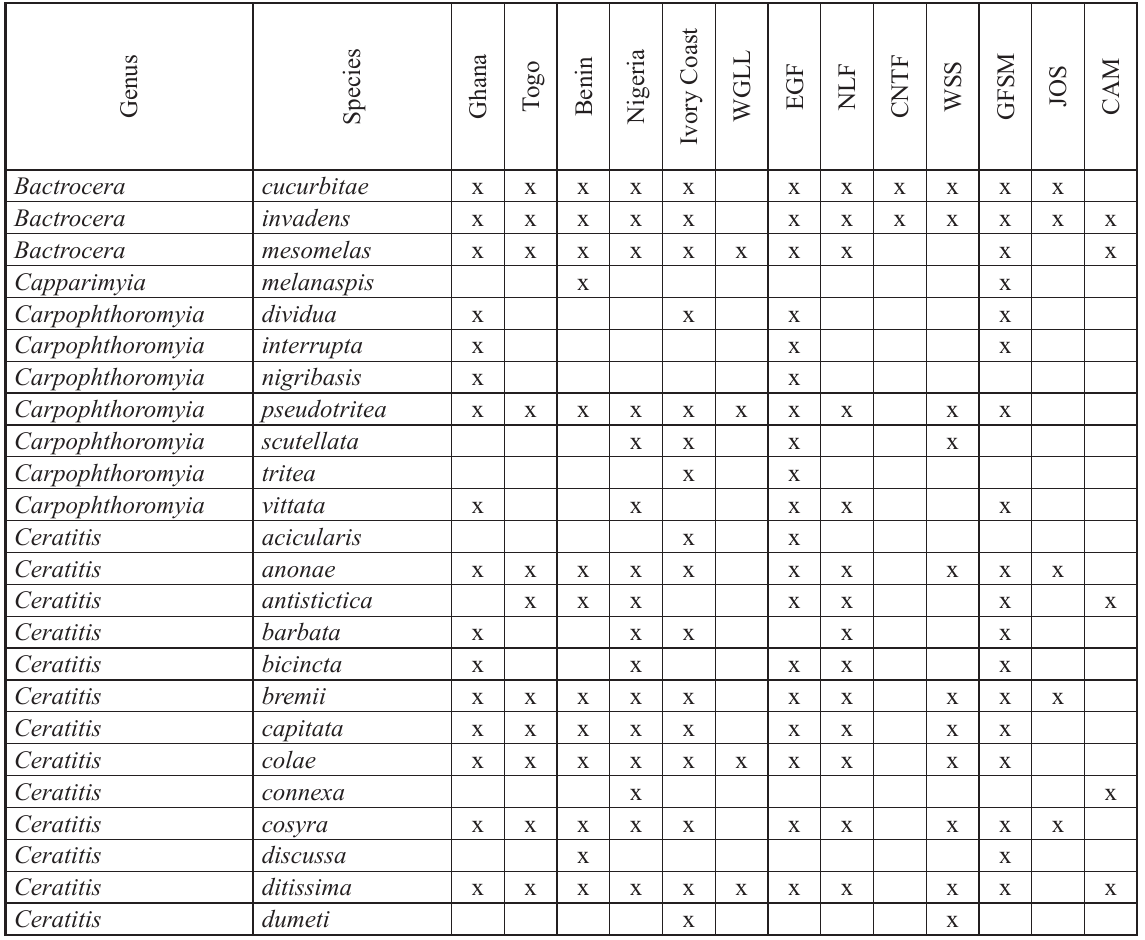
Table 1. List of tephritidae recorded from the different countries and ecoregions in the study area. (abbreviations: WGLL = West Guinean Lowland Forest; EGF = East Guinean Forest; NLF = Nigerian Lowland Forest; CNTF = Cross-Nigerian Transition Forest); WSS = West Sudanian Savannah; GFSM